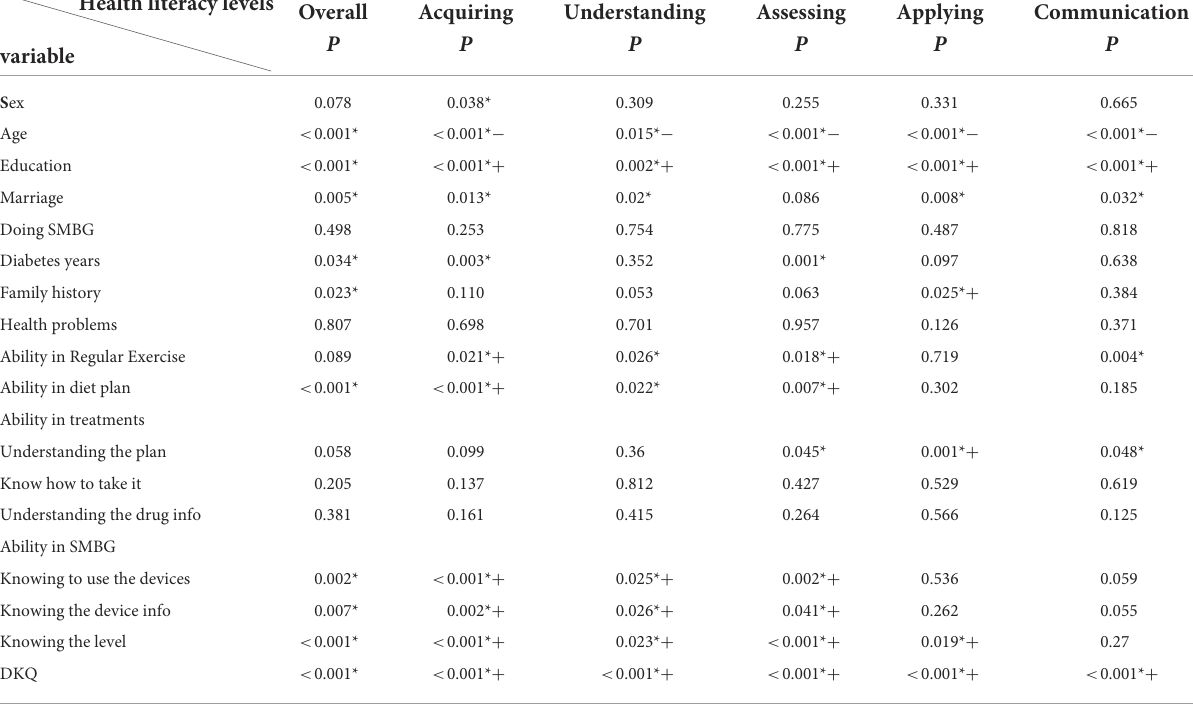
TABLE 4 The relationship between overall and sub-dimensions health literacy levels (MMHLQ) with other variables. Health literacy levels Overall variable